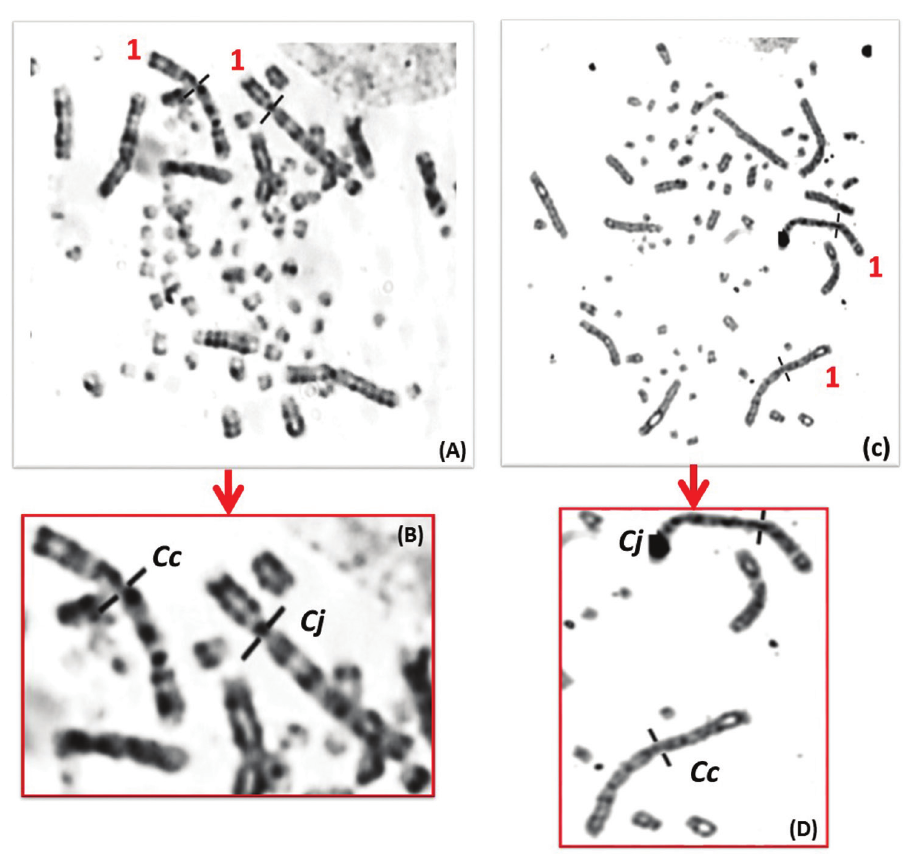
Figure 4. A, C Prometaphase spreads following the GTG-banded chromosomes of hybrid quail B, D Black traits indicate the centromere positions of the homologous chromosomes 1 which are morphologi- cally